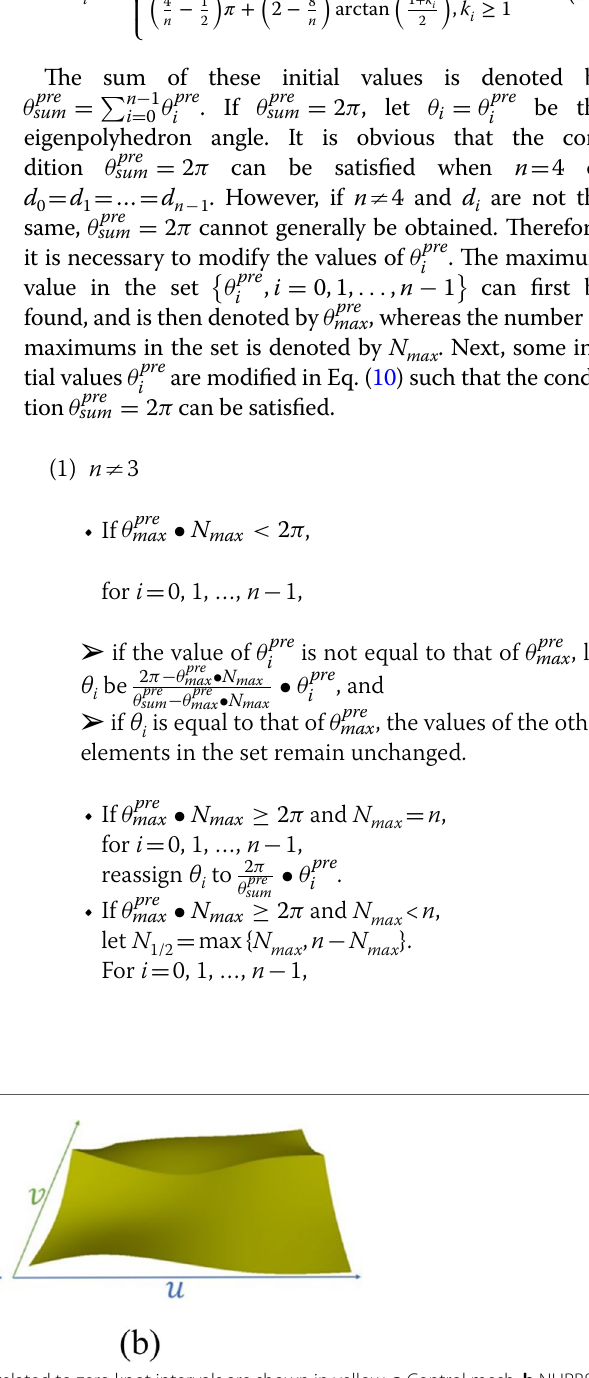
Fig. 4 Notations for a crease edge in a NURBS surface, where the edges related to zero knot intervals are shown in yellow. a Control mesh; b NURBS